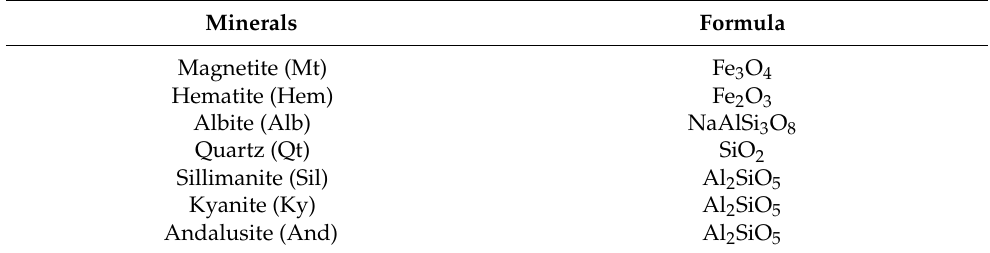
Table A3. Pure minerals included in the modeling of altered marine basalt. The thermodynamic properties of the pure minerals are from Holland and Powell [19].